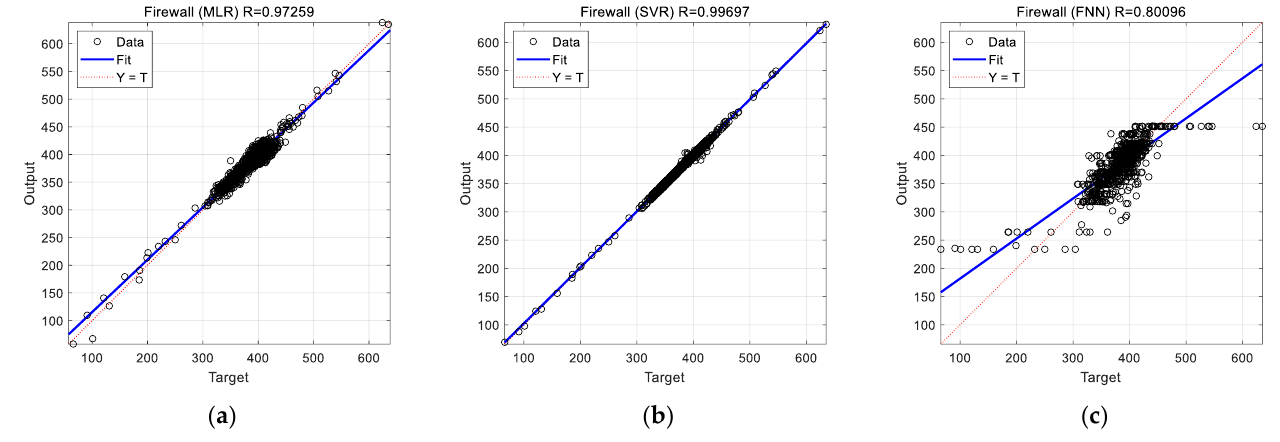
Figure 7. Firewall regression plot: ( a ) MLR; ( b ) SVR; and ( c ) FNN.